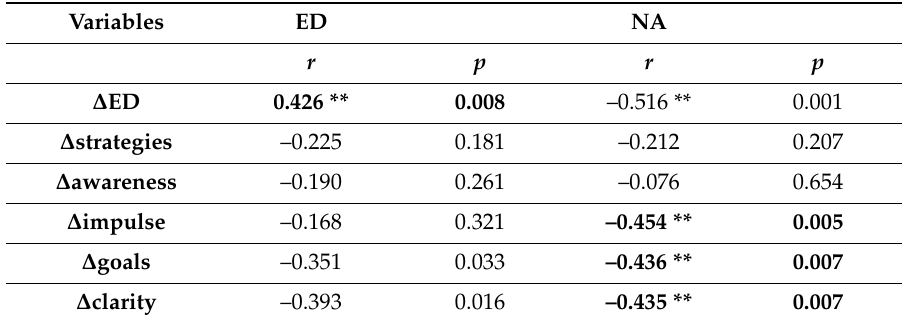
Table 14. Correlations between variables (Pearson’s coe ffi cients): ∆ / ED; ∆ / NA; blood cancer group ( n = 46); ( ∆ —“instability coe ffi cients”; ED—emotion dysregulation; NA—negative a ff ect).